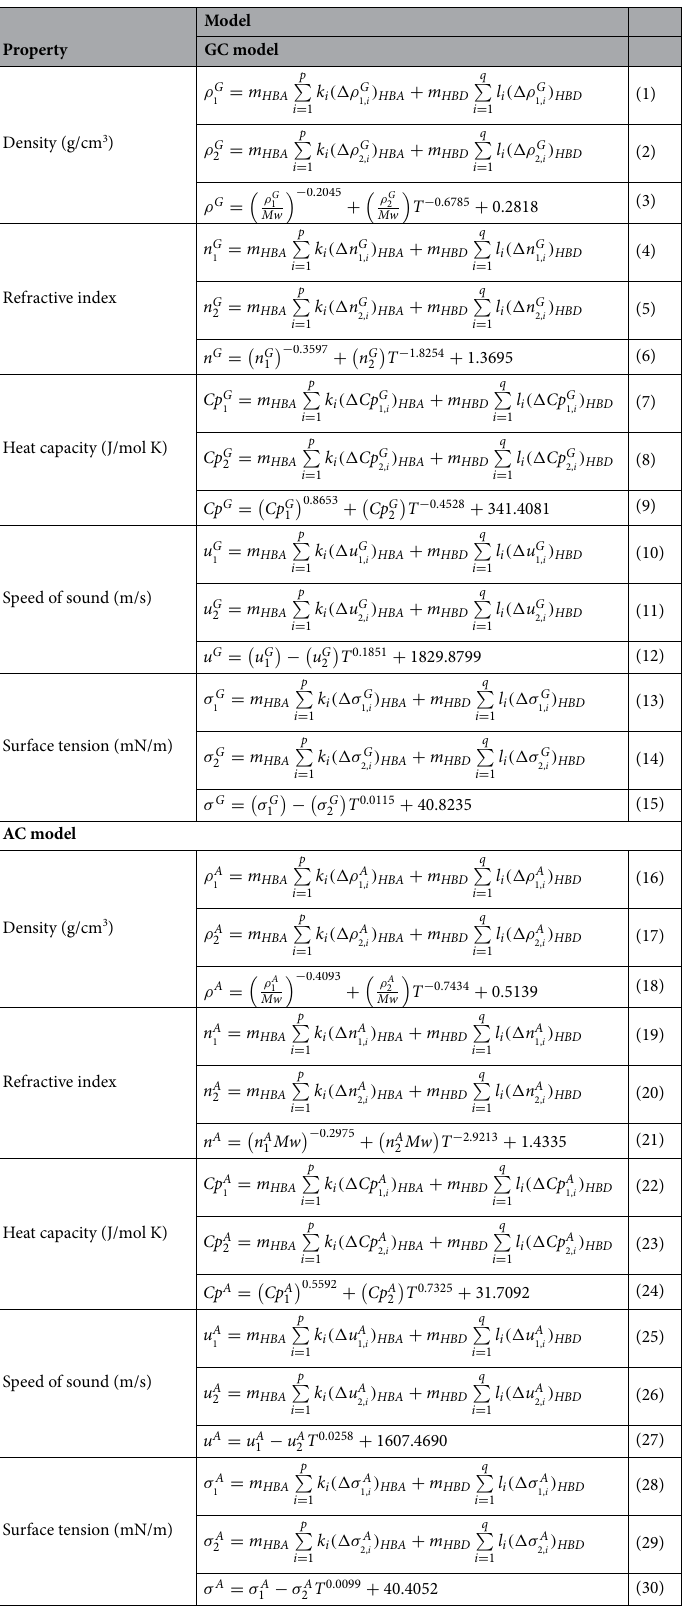
Table 1. The list of proposed AC and GC models for density, refractive index, heat capacity, speed of sound and surface tension of DESs at atmospheric